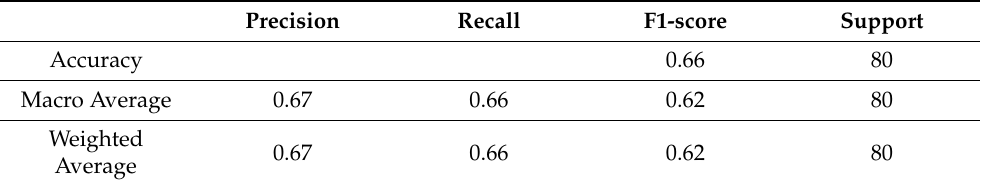
Table 10. Evaluation metrics report with random forest classifier for testing set encrypted with slightly different